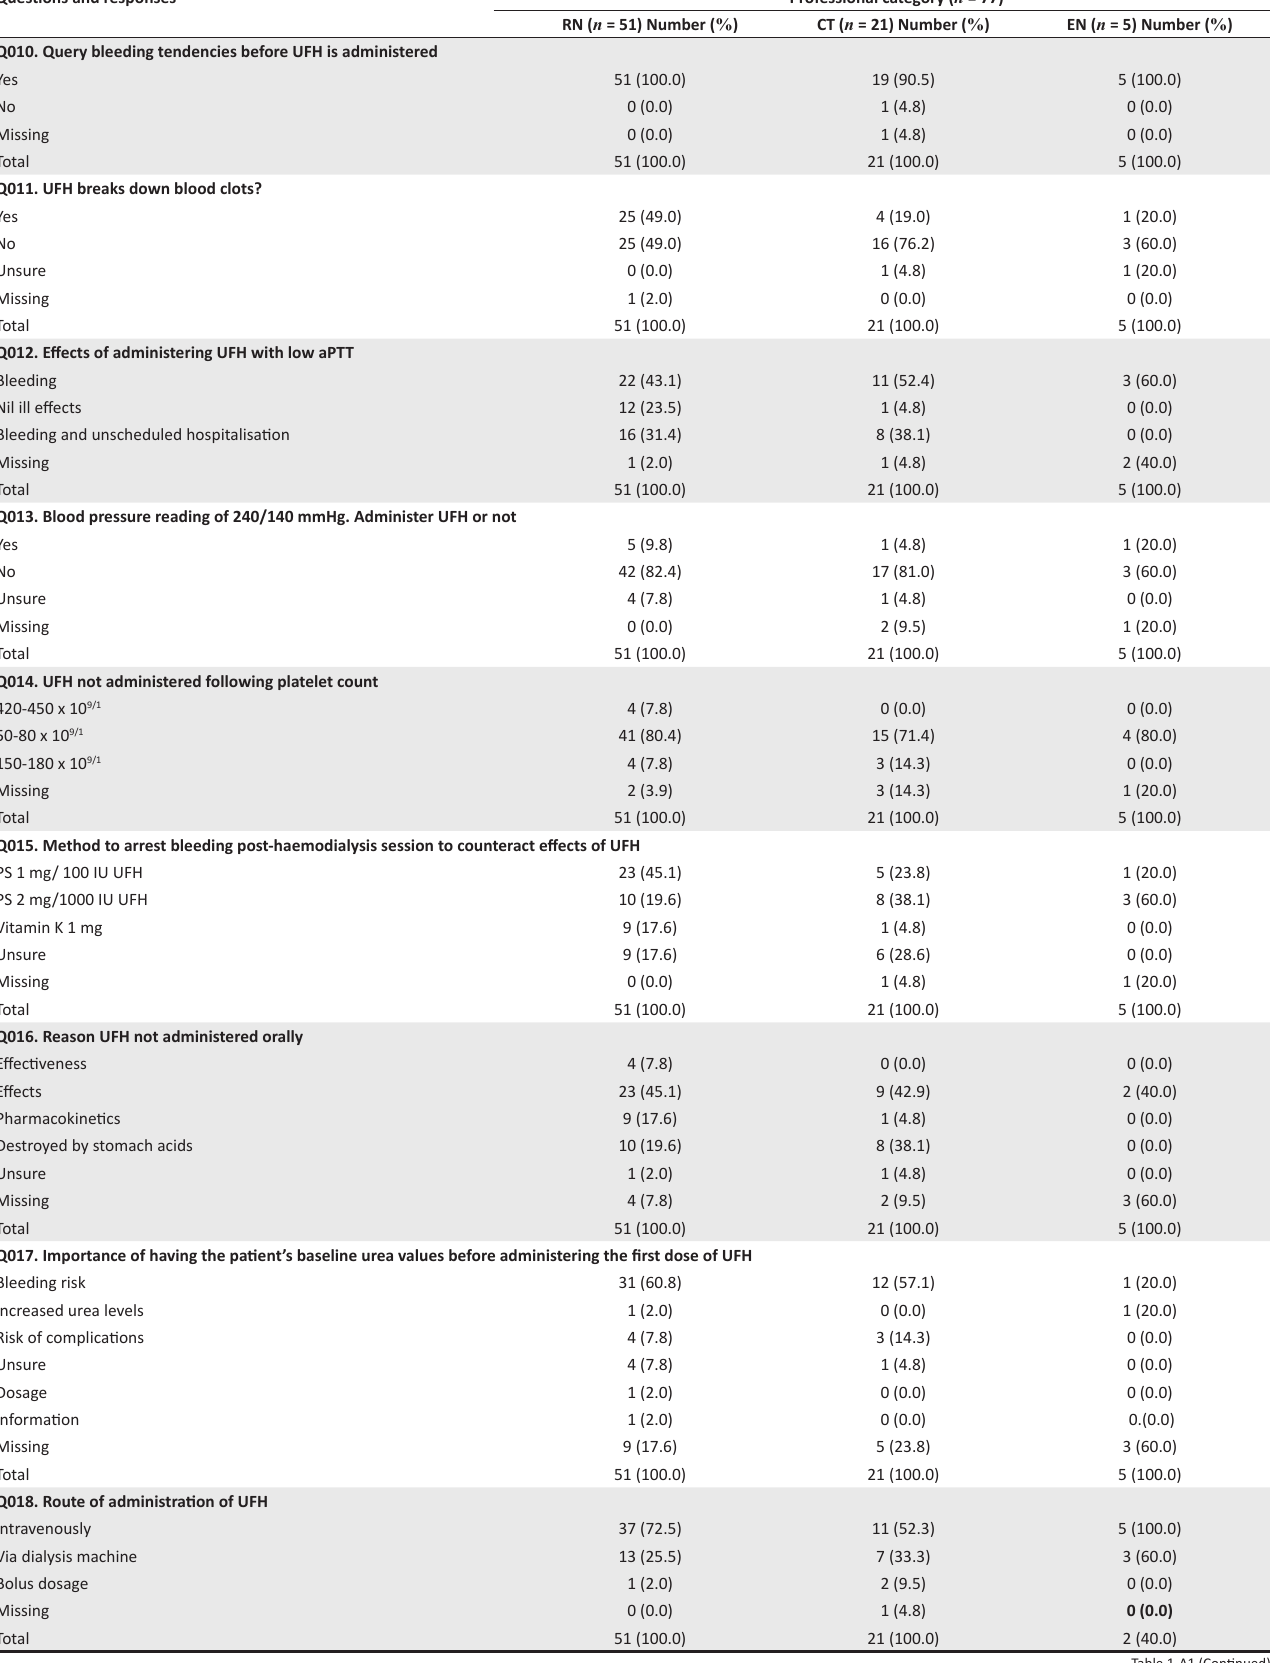
TABLE 1-A1: Respondents’ self-reported knowledge results by professional